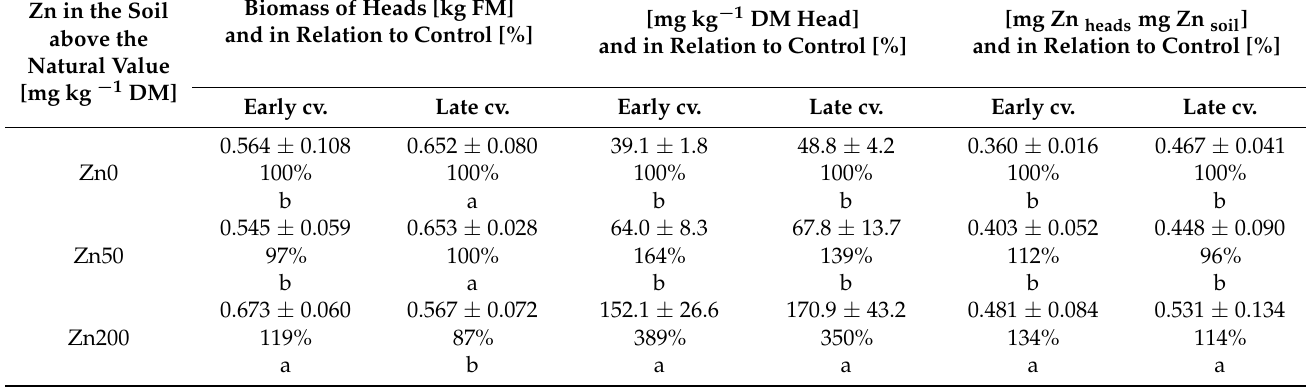
Table 3. Biomass of heads and zinc accumulation by cabbages grown in unspiked soil and the soil spiked with zinc. The natural content of zinc in the Zn0 (control) object was 118.13 [mg kg − 1 DM]. The early cultivar was grown for 13 weeks, the late one for 21